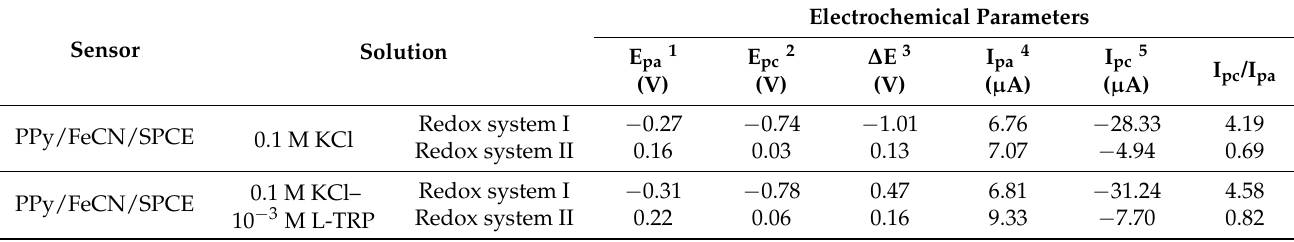
Table 3. The potentials and currents of the peaks of PPy-modified sensors and immersed in a 0.1 M